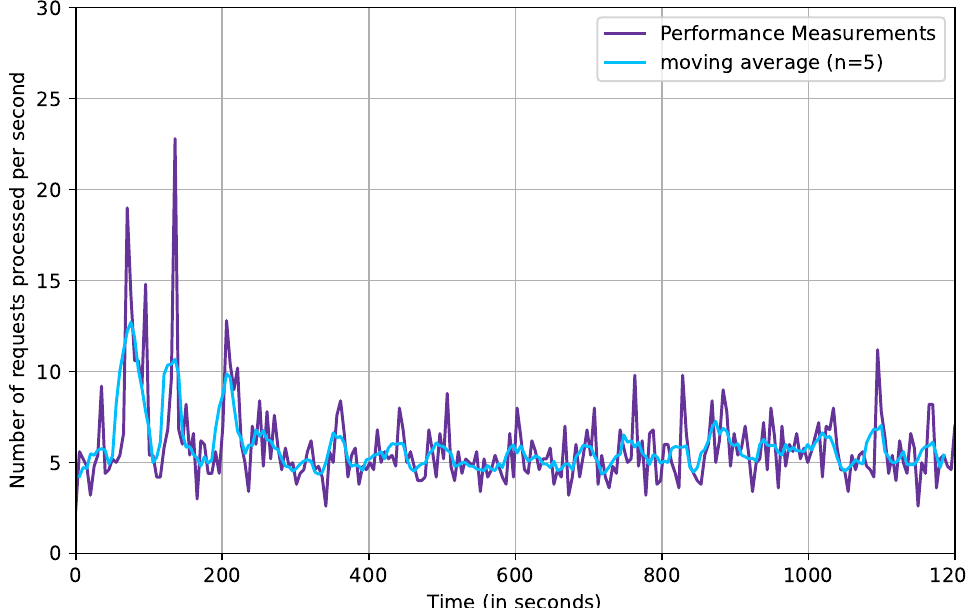
Figure 11. The obtained results from stress-testing the system with persistent queues over the course of 1200s. The number of requests are measured and reset every 5 s. The plot shows the average number of requests processed per second over each 5 s interval. The moving average is computed with a window size n =